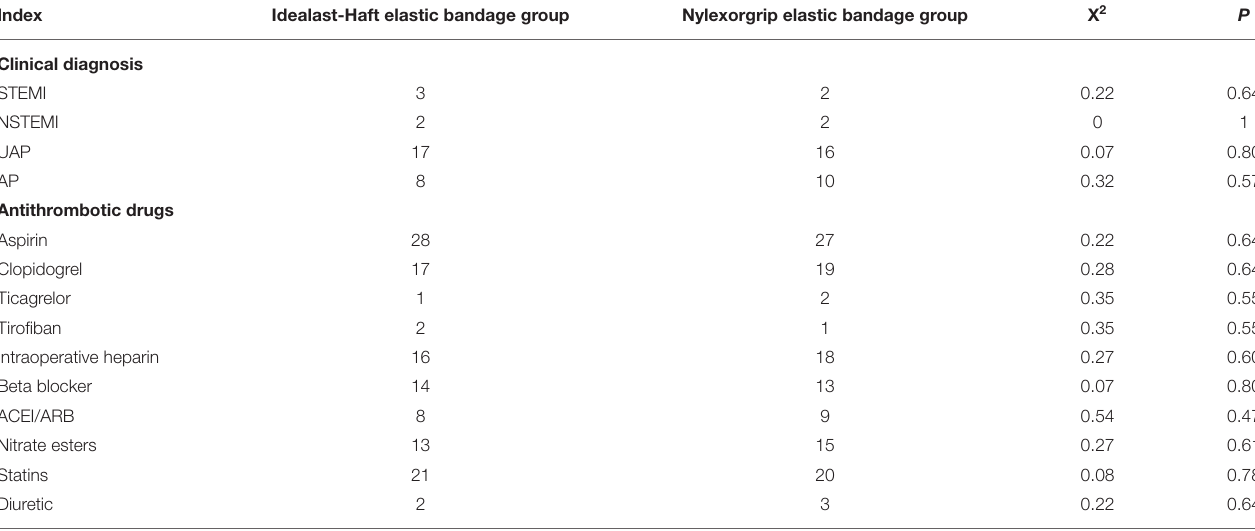
TABLE 3 | Diagnosis and drug treatment.